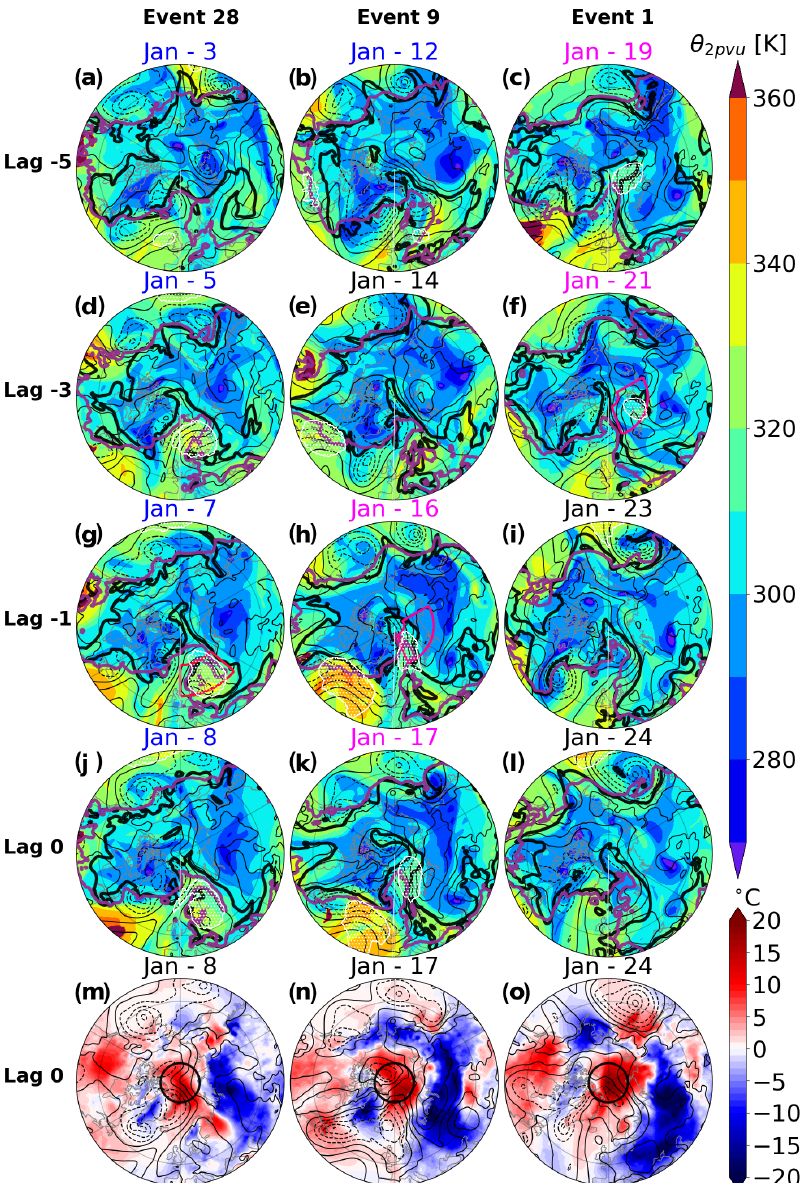
Figure 3. Synoptic situation prior to three warm extreme events (columns) between 3 and 24 January 2006 at 12:00UTC at lags − 5, − 3, − 1 and 0d relative to each warm event (rows). Panels (a) – (l) show potential temperature ( θ ) on the dynamical tropopause, defined by the 2pvu isosurface (shading), SLP (hPa, black contours every 10hPa, solid for SLP > 1000hPa), total column water (thick black solid for 5kgm − 2 ) and T2m (purple solid at 0 ◦ C). White-dotted areas indicate regions with identified blocks. Magenta and red boxes indicate the Ural (h, f) and Scandinavian (g) blocking sectors, respectively. Panels (m) – (o) show T2m anomalies (shading) and SLP contours at 12:00UTC of each warm event (lag 0d). The black circle shows the latitude line at 80 ◦